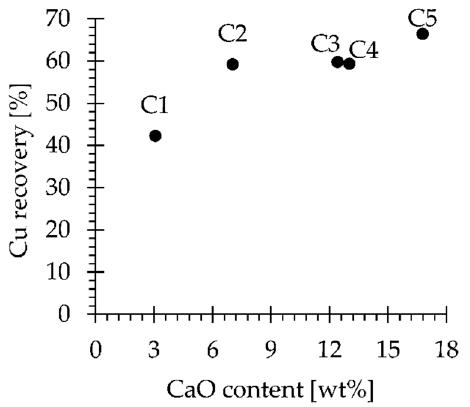
Figure 5. Copper recovery between the copper phases and the slag phase.